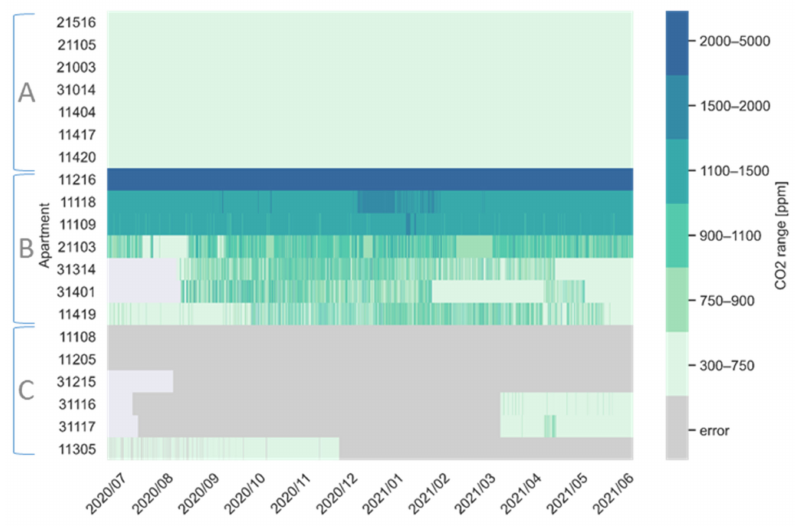
Figure 32. Hourly values of CO 2 index from selected